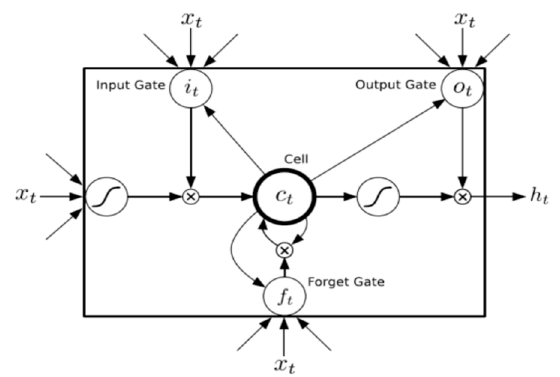
Figure 1. Long Short-Term Memory cell .